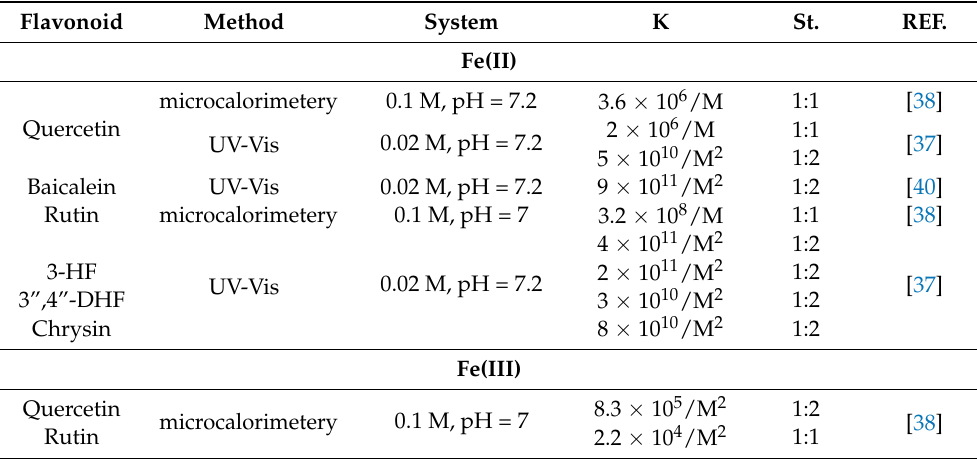
Table 1. Binding constants of flavonoid complexes with iron ions in the phosphate buffer. Flavonoid Method